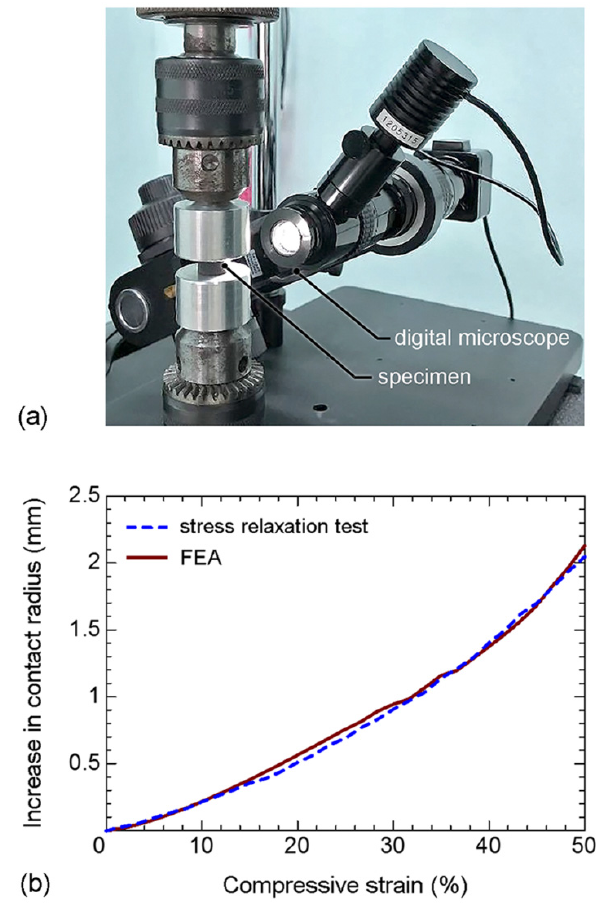
Figure 12. ( a ) Measurement of an increase in the contact radius of disc-A during the stress relaxation experiment; and ( b ) increases in the contact radius of disc-A during stress relaxation experiment (50% peak strain).